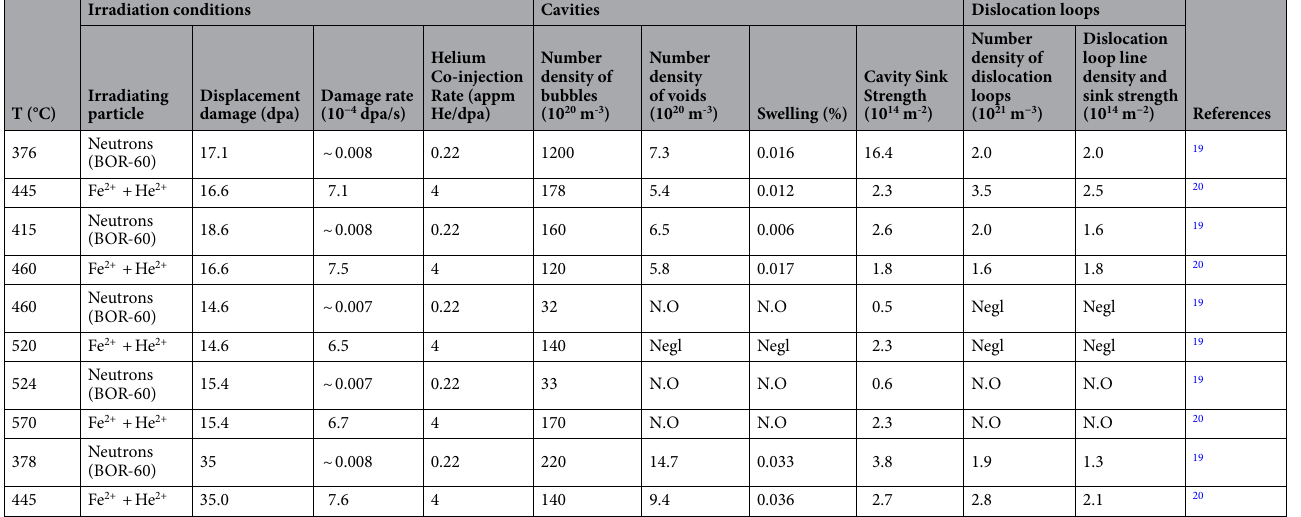
Table 1. Summary of characterization results for cavities and dislocation loops in irradiated T91 to use as input parameters. Error in number densities (not shown) is due to TEM foil thickness measurement and is estimated to be 10%. Error in swelling (not shown) is estimated to be about 27% from standard error propagation techniques. N.O. means the feature was not observed. Negl. means the feature was observed but not found in a sufficient amount to form statistically significant values.